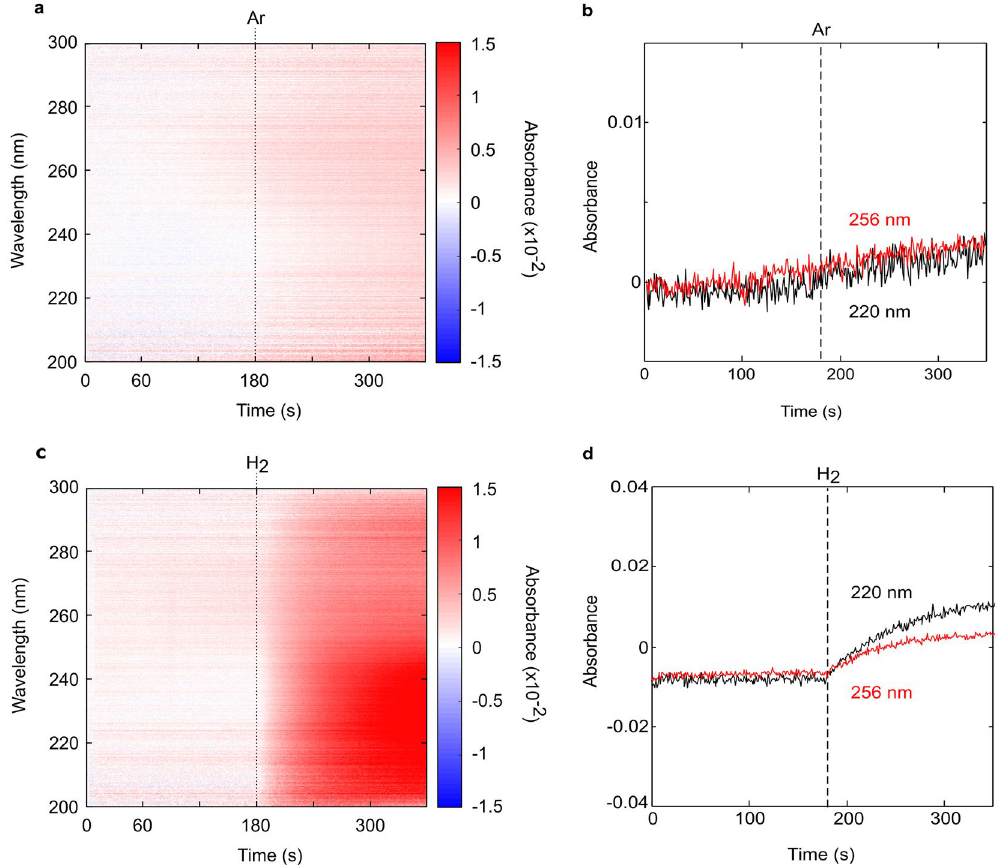
Figure 4. High temperature absorbance spectra of argon and hydrogen post-cleaning. ( a ) Time evolution of the absorbance and ( b ) line profiles of the 220 nm and 256 nm peaks for hydrogen; ( c ) Time evolution of the absorbance and ( d ) line profiles of the 220 nm and 256 nm peaks for Argon. Lines at 180 s denote when the respective gases are added in